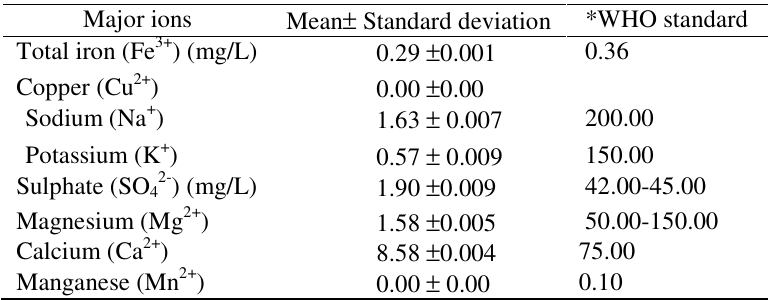
Table 1. Major ions in the treated water